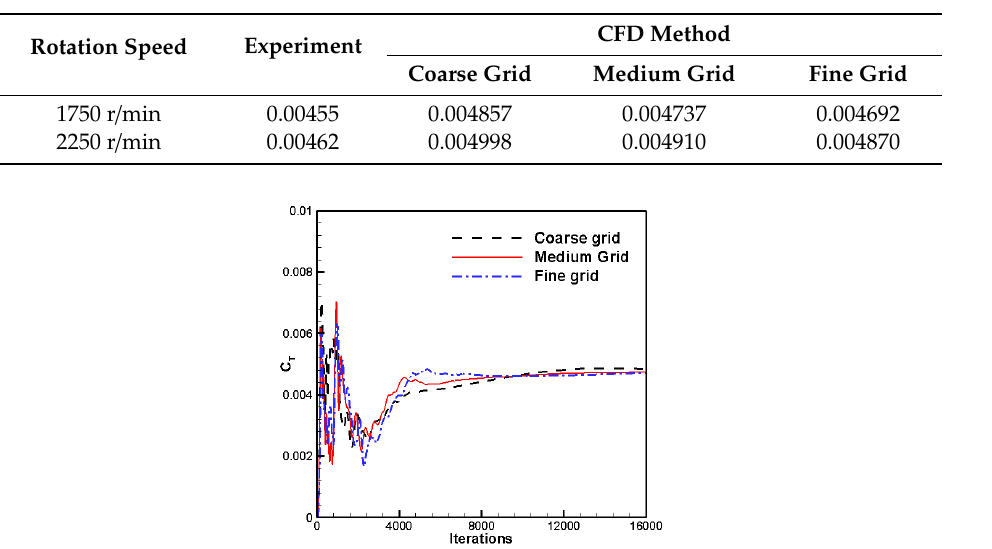
Table 2. Rotor thrust coe ffi cients C T at di ff erent rotation speeds.